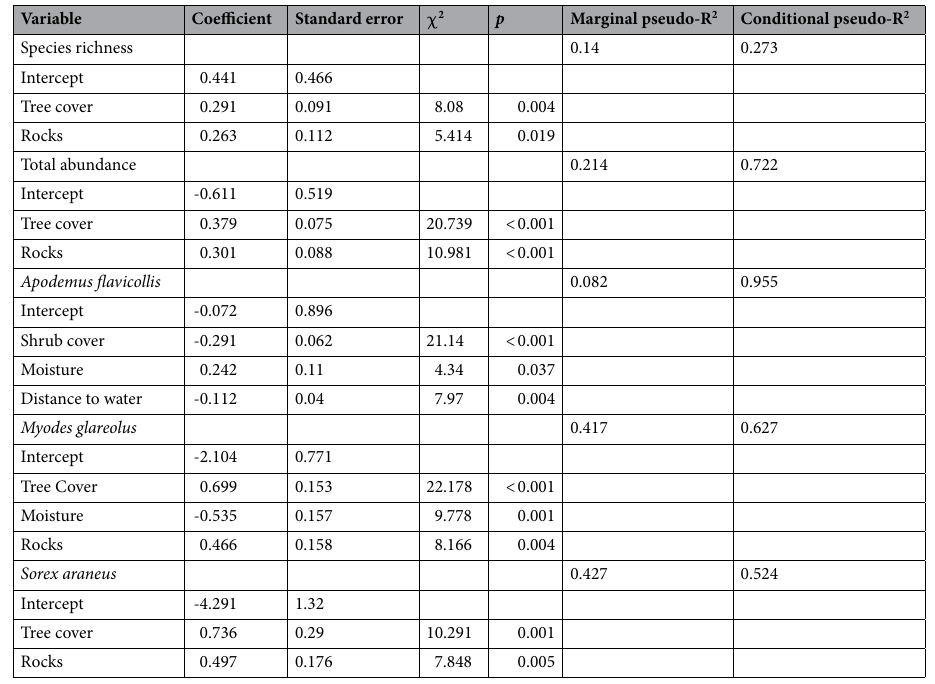
Table 2. Parameters of the fixed effects in the best GLMMs including species richness, total abundance and abundance of the three dominant species as response variables, habitat characteristics as fixed effects and year as random factor. Significance of predictors was tested using the likelihood-ratio test. Marginal pseudo-R 2 represents the variance explained only by the fixed part of the model and conditional pseudo-R 2 represents the variance explained by the entire model.